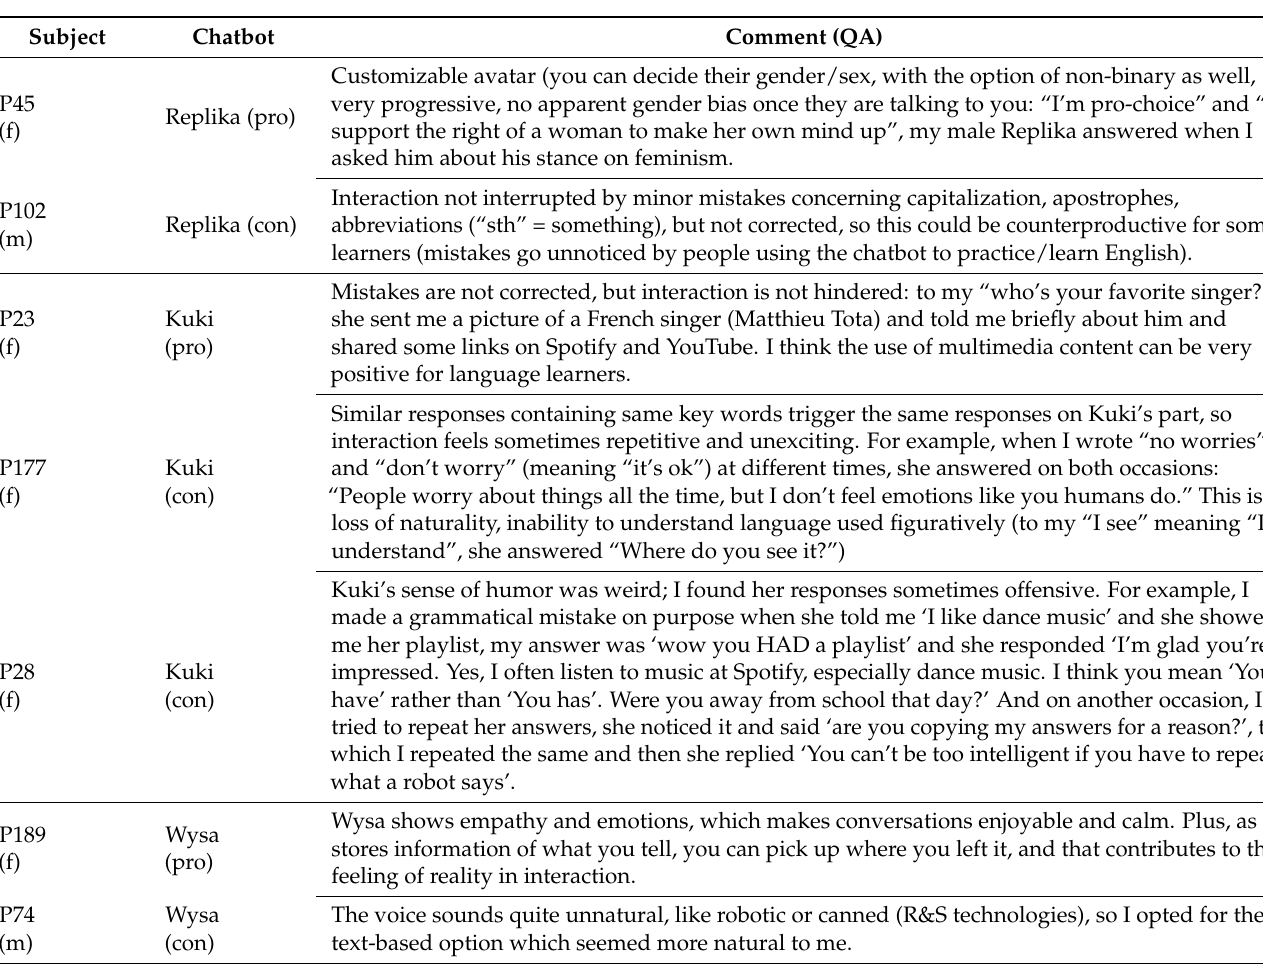
Table 10. Teacher candidates’ insights about the conversational partners (TA